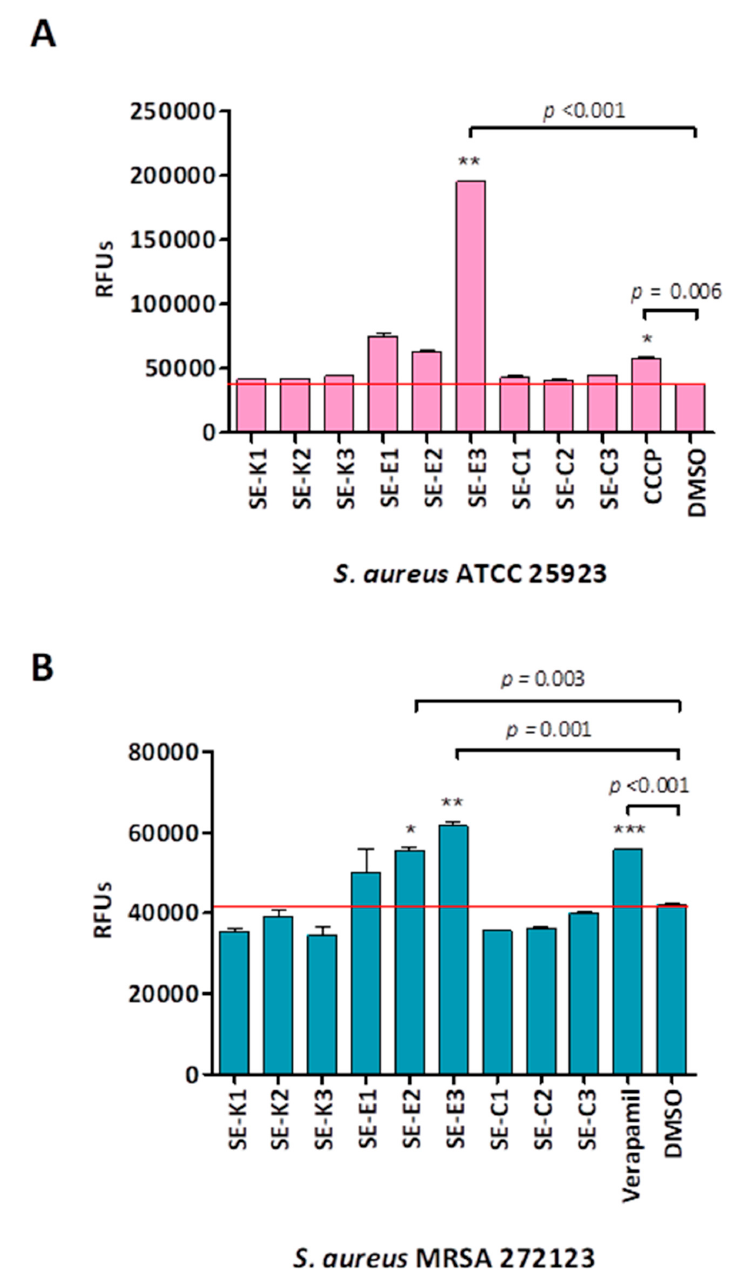
Figure 2. EB accumulation on S. aureus strains. The graphs show the RFUs of ( A ) S. aureus ATCC 25923 ( B ) S. aureus MRSA 272123 bacterial strains in the presence of the compounds in the 60th minute of the assay. In case of S. aureus ATCC 25923 the levels of significance were * p = 0.006 and ** p < 0.001. The levels of significance were * p = 0.003, ** p = 0.001, and *** p < 0.001 on S. aureus MRSA 272123.